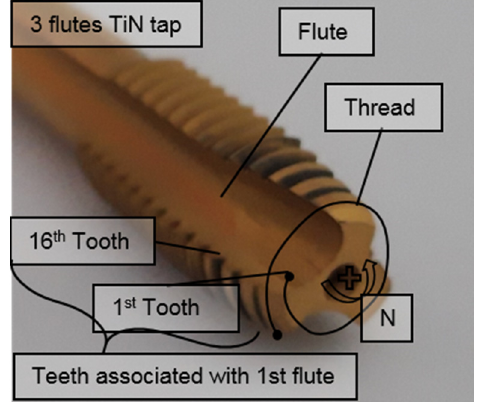
Figure 3. Nomenclature used in taps.